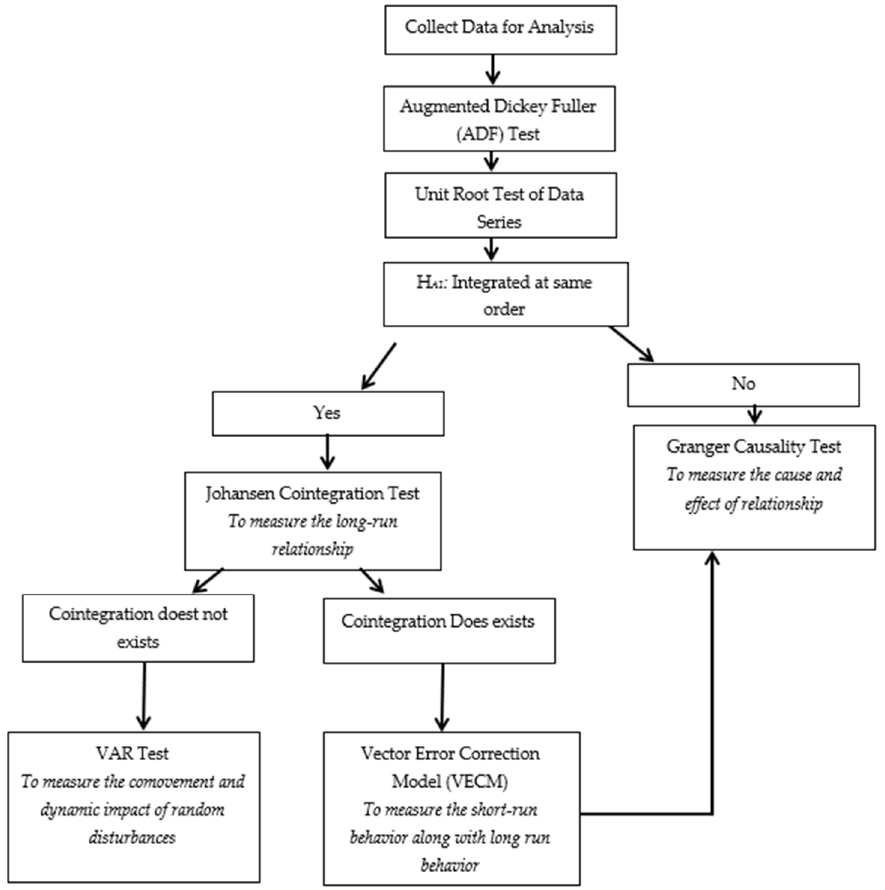
Figure 2. Flowchart of